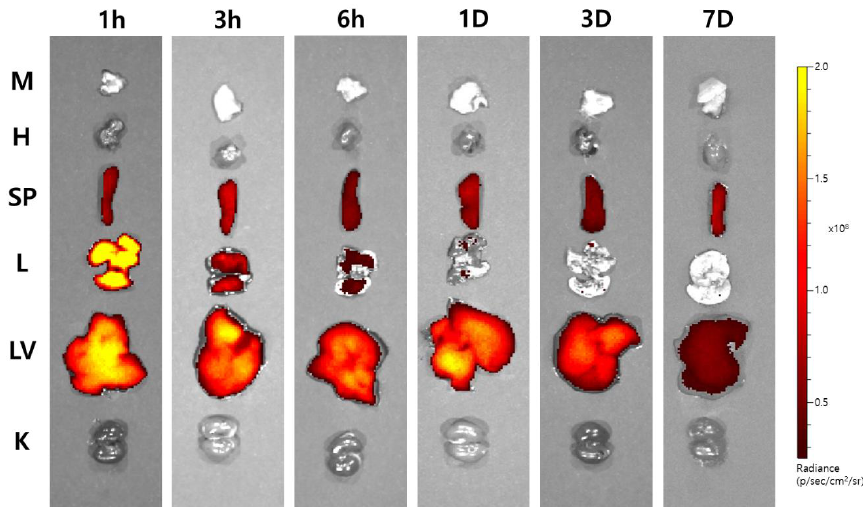
Figure 4. Ex vivo fluorescence images of OVA-induced asthmatic mice at 1 h, 3 h, 6 h, 1 days, 3 days, and 7 days after injection with Cy7-labeled Cur-PLGA-DPPs ( n = 3 per group). The following organs were examined: muscle (M); heart (H); spleen (SP); lungs (L); liver (LV); kidneys (K). Data are shown in p/sec/cm 2 /sr.